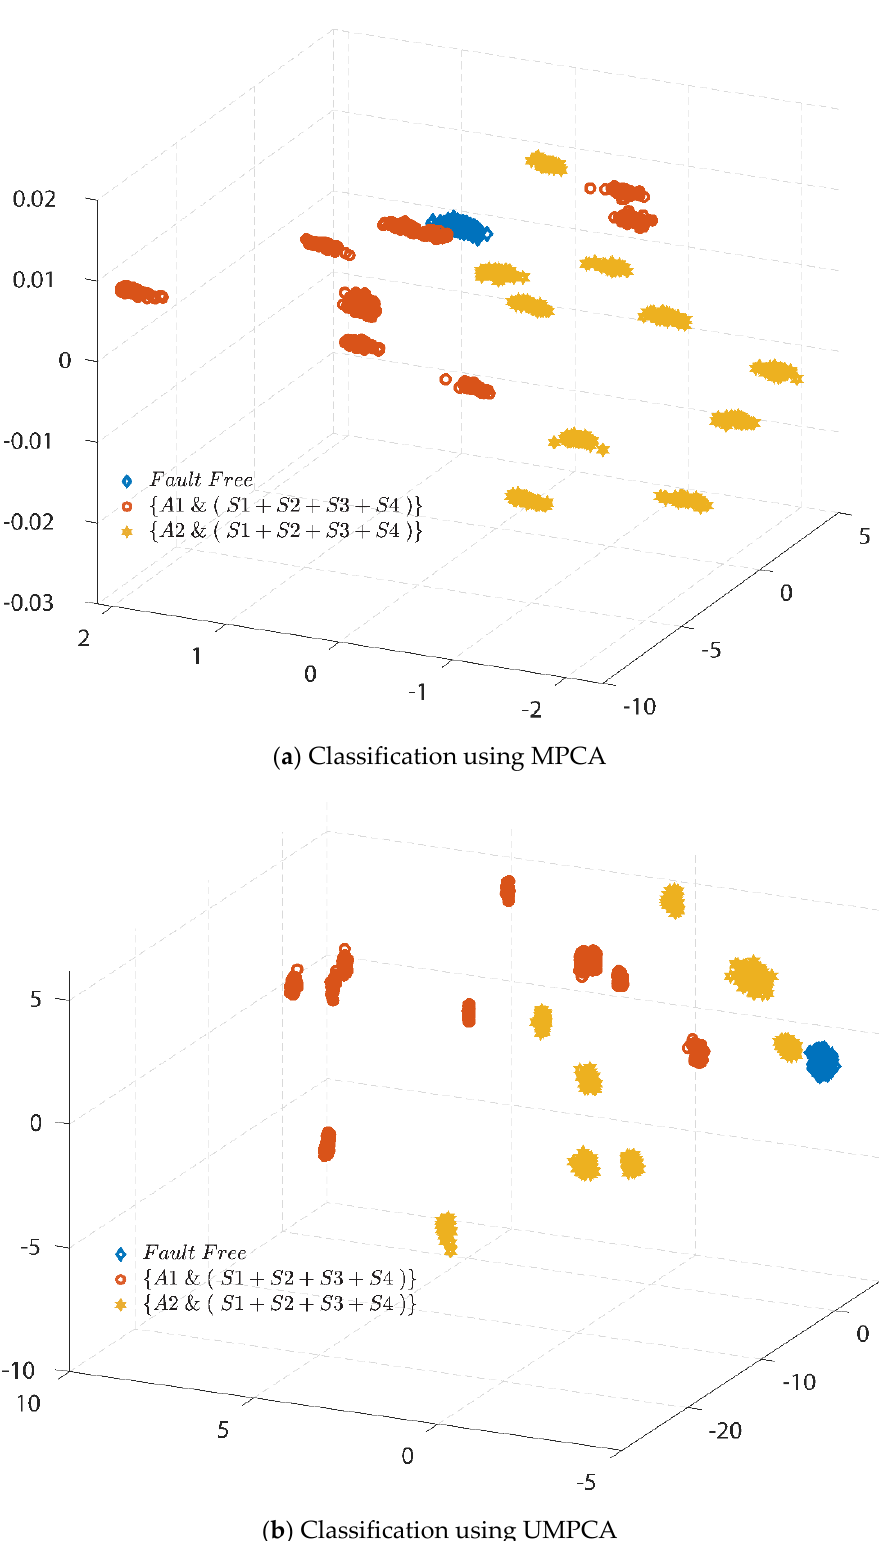
Figure 12. Three-dimensional space visualization performance for fault classification for wind turbines subject to single actuator and four sensor faults under AWGN noises, using ( a ) MPCA and ( b ) UMPCA, respectively.